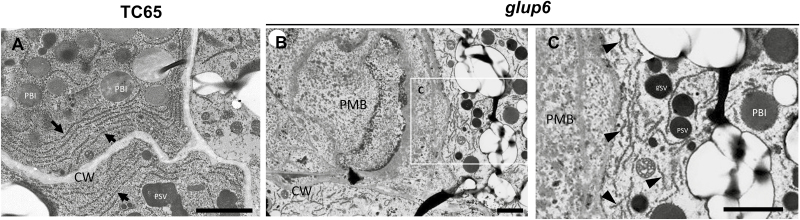
Transmission electron micrographs depicting the ER in wild-type and glup6 endosperm. (A) Wild-type TC65 and (B, C) glup6. (C) Shows an enlarged image of the area indicated in (B). The arrows in (A) indicate the layers of cisternal-ER membrane in the wild-type. The arrowheads in (C) indicate the dispersed ER in glup6. Scale bars are 2 μm.